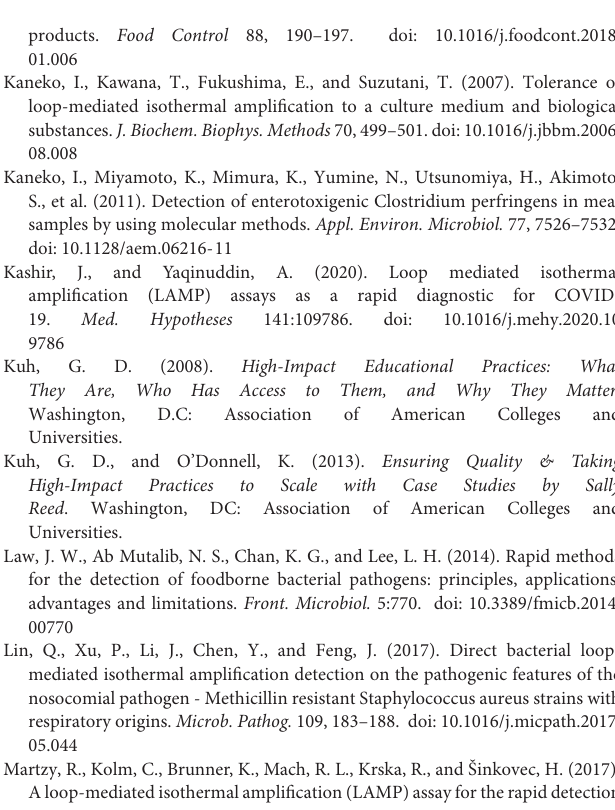
Supplementary Figure 1 | Comparison of DNA amplification using PCR (A) or LAMP (B) . PCR requires the use of a thermocycler and electrophoresis equipment (A) . In LAMP, self-priming obviates the need for a thermocycler, and colorimetric readout provides an alternative to electrophoresis (B) . Supplementary Figure 2 | Schematic diagram of LAMP. Part 1. Template DNA with primer target sequences indicated (F3c, F2c, and F1c). Part 2. Primer FIP binds to target sequence F2c, with a 5 (cid:48) overhang containing F1c (top panel). Primer F3 is used to unzip and release strand A2 (middle panel), which then forms a loop at its 5 (cid:48) end via F1c-F1 complementarity (bottom panel). Part 3. The 3 (cid:48) end of strand A2 is targeted by primer BIP, followed by unzipping with primer B3 to release strand A4, which can forms loops at both 5 (cid:48) and 3 (cid:48) ends. Part 4. The resulting dumbbell (strand A4) is comparable to a similar dumbbell (strand B4) formed by a corresponding series of events (not shown) beginning with targeting of B2c in strand B ( Part 1 ). Part 5. Loop amplification yields concatemers of target sequences, beginning either with strand A4 ( Part 5a ) or with strand B4 ( Part 5b